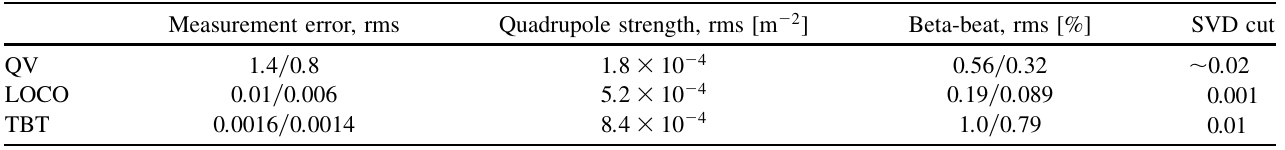
TABLE II. Statistical errors evaluated from repeated measurements and SVD cuts. The measurement errors for the three different methods are incommensurable because they are the rms fluctuation of the average beta normalized by the model value in units of % for QV, the orbit response in units of m = rad for LOCO, and the phase advance between BPMs in units of 2 (cid:3) for TBT. Single TBT measurement corresponds to an average of four measurements, profiting from the fast data acquisition. Measurement error, rms Quadrupole strength, rms [ m (cid:1) 2 ] Beta-beat, rms